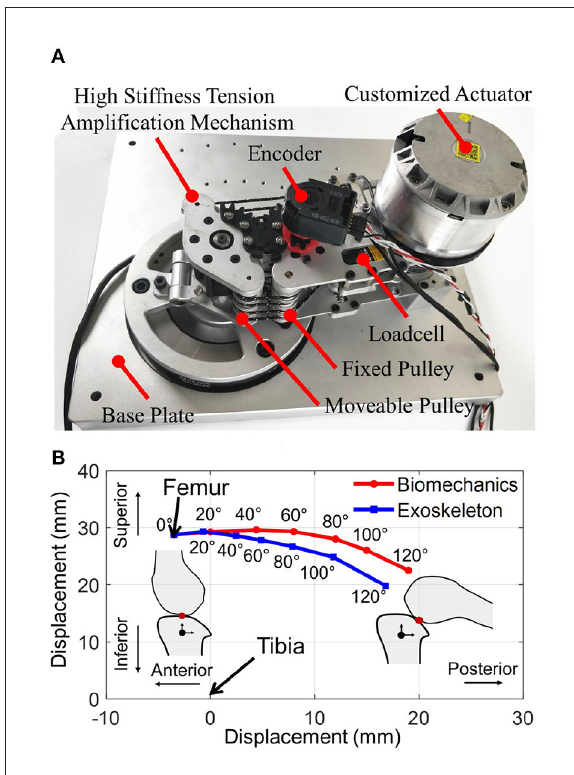
FIGURE8 (A) Bench test platform that fixes the thigh and shank links of the joint mechanism; (B) The knee center of rotation displacement result shows our proposed rolling gear based knee joint can reduce joint misalignment and biomimic the rotation trajectory of the biomechanics of the human knee joint.